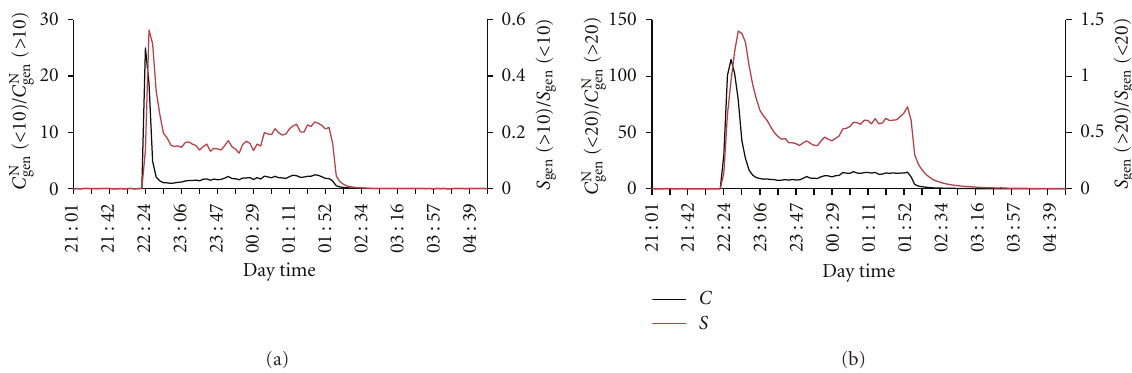
Figure 24: Conditions of general aerosols during burning of a candle on January 5-6: (a) ratio of the number concentration of aerosol ( < 10)) to that of bigger ones ( C N ( > 10)) and ratio of the total surface area of all particles smaller than particles smaller than 10 nm ( C N gen gen 10nm ( S gen ( < 10)) to the total surface area of all particles bigger than 10nm ( S gen ( > 10)) in a volume unit and (b) ratio of the number ( < 20)) to that of bigger ones ( C N ( > 20)) and ratio of the total surface area of all concentration of aerosol particles smaller than 20nm ( C N gen gen particles smaller than 20nm ( S gen ( < 20)) to the total surface area of all particles bigger than 20nm ( S gen ( > 20)) in a volume